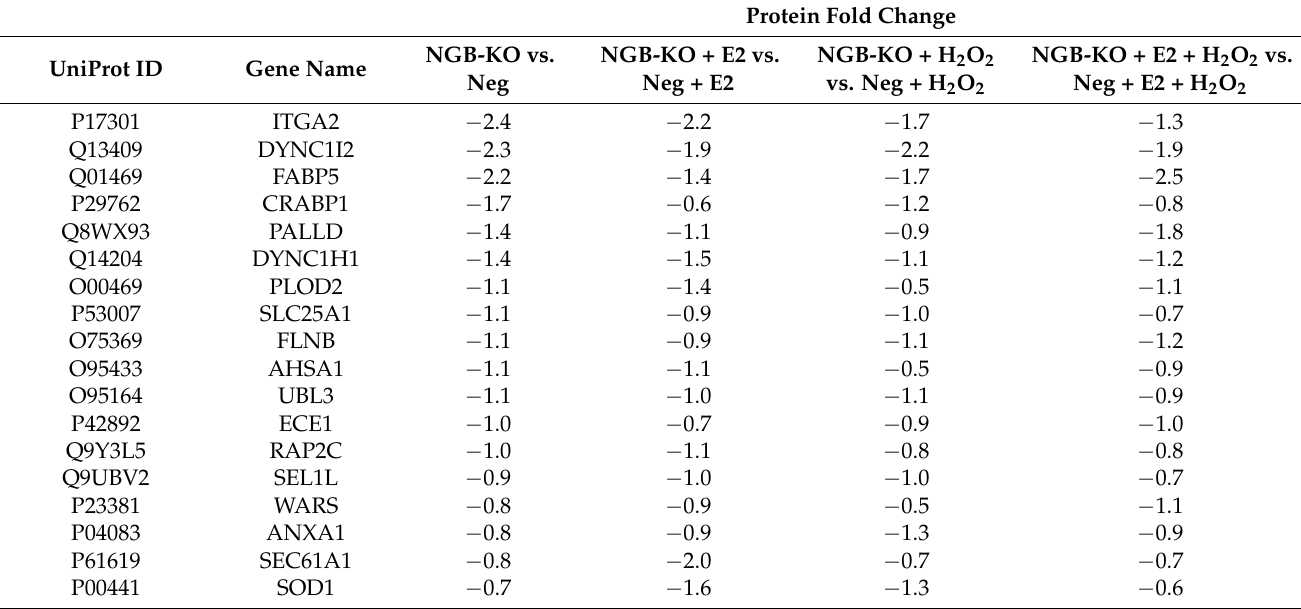
Table 3. Common protein dataset in all NGB-KO comparisons with fold changes. Protein Fold